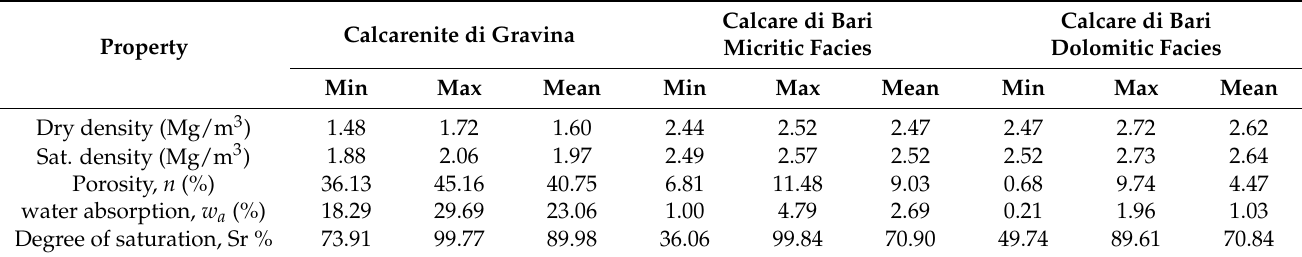
Table 1. Physical properties of the materials cropping out at the study